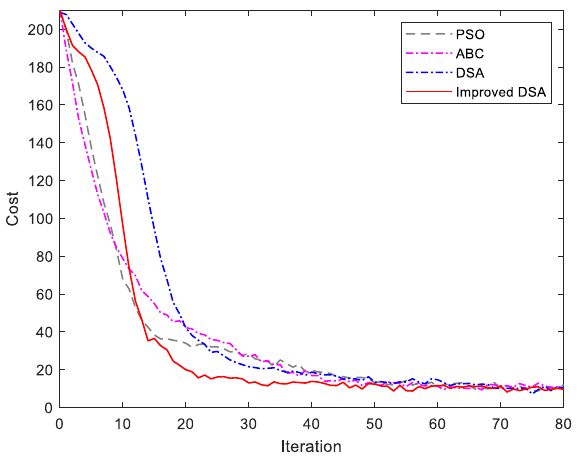
Figure 9. Evaluation of improved DSA algorithm under 100 individuals. Table 2. Simulation results in case (1): 10 individuals.